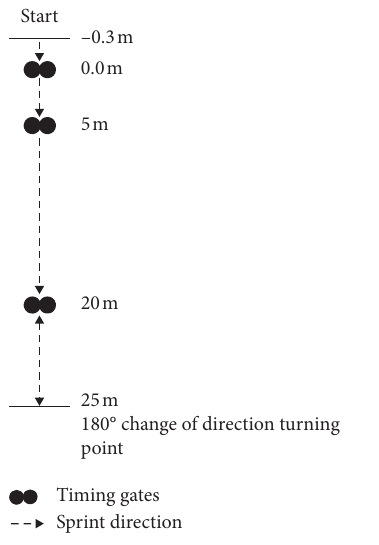
Figure 1: Schematic diagram of test